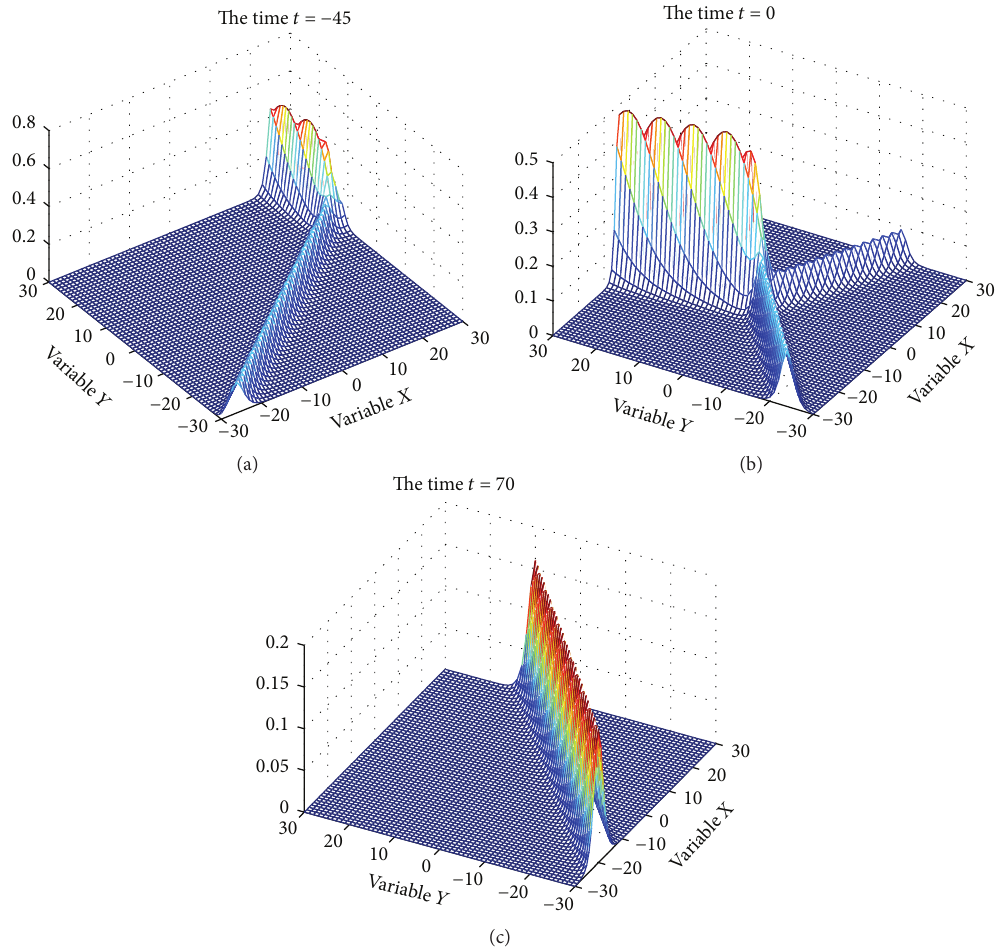
Figure 2: The process of the soliton fusion for the two solitary waves (46) with 𝑘 1 = −0.8 , 𝑘 2 = 0.6 , 𝑝 1 = −1.25 , and 𝑝 2 = 2 , and (a) implies 𝑡 = −45 , (b) implies 𝑡 = 0 , and (c) implies 𝑡 = 70